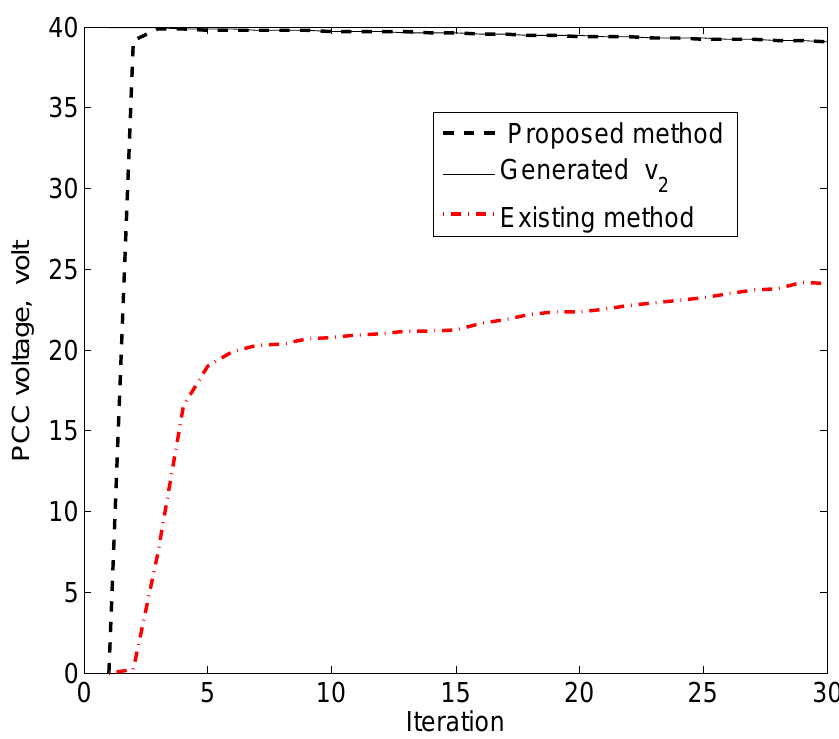
Figure 15. PCC voltage estimation for v